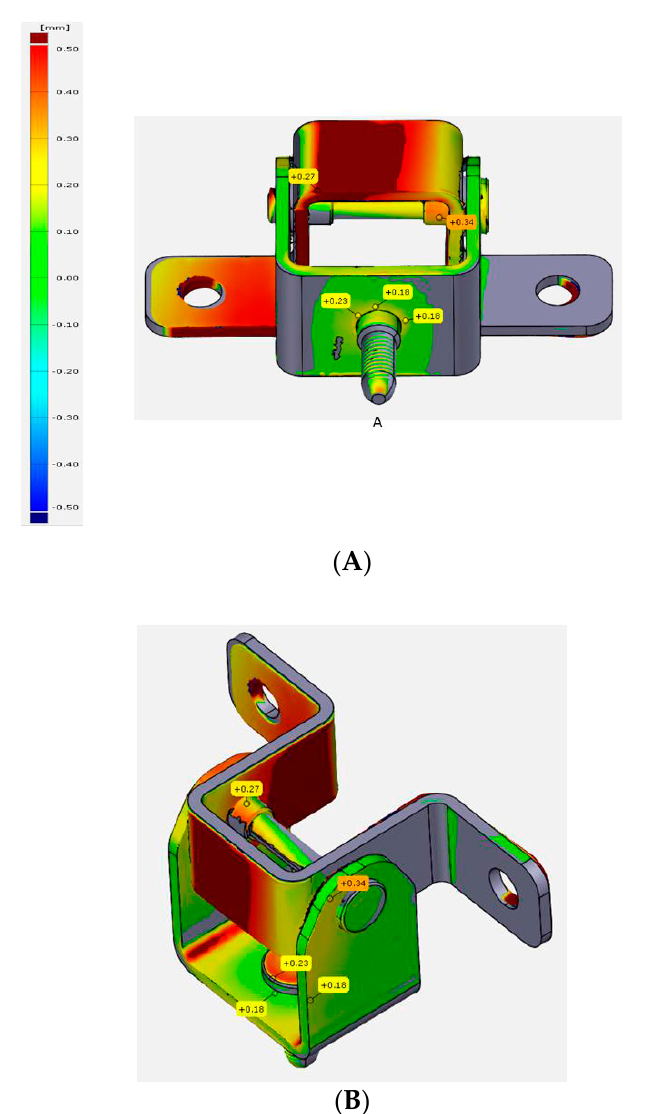
Figure 11. 3D Scanning results of dummy door hinge (( A ): bottom view, ( B ) right view). In the plot, colors from green to red colors indicate the distance, which is outside from the reference geometrical data. Colors from green to dark blue indicate the distance, which is inside of reference geometrical data, grey color indicates the reference geometrical